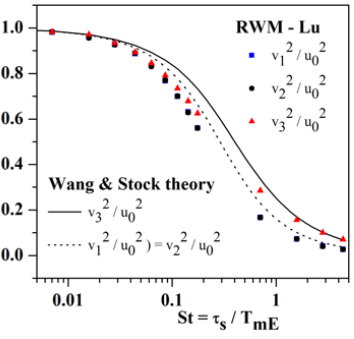
Figure 15. Normalized variance of particle velocity (g ≠ 0).